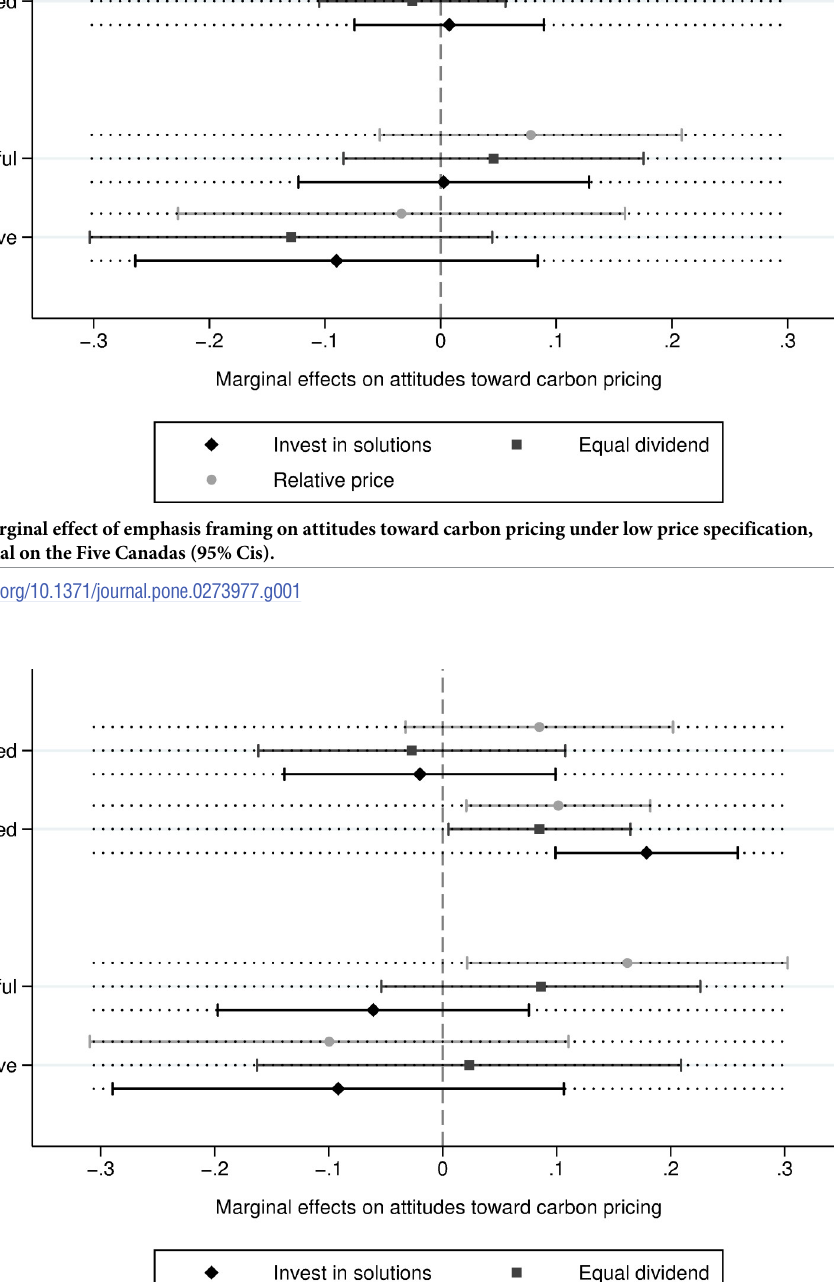
PLOS ONE | https://doi.org/10.1371/journal.pone.0273977 November23,